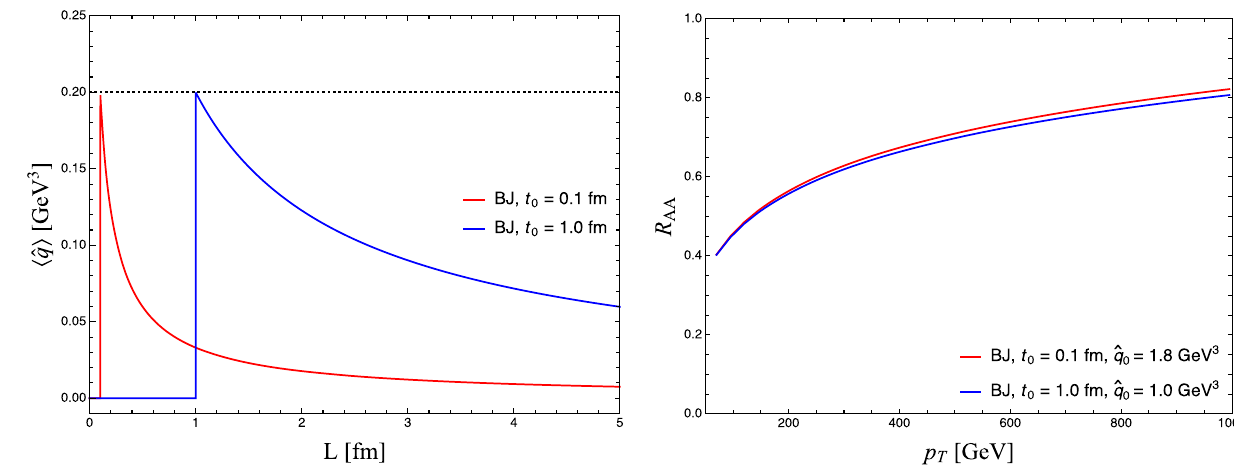
Fig. 3 Left:The ˆ q asafunctionofthelengthofmedium, L ,forBjorken medium for two values of initial time of quenching, t 0 = 0 . 1 fm and t 0 = 1 . 0 fm. Right: Jet suppression factor R AA as a function of p T